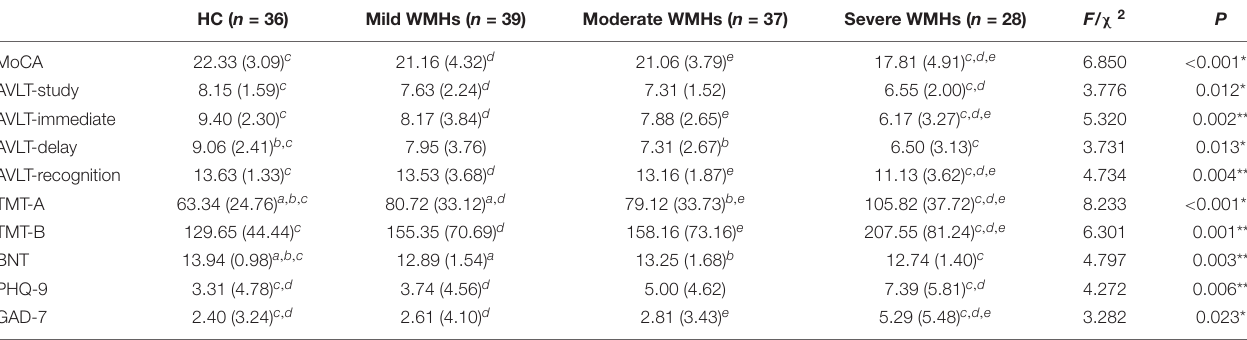
TABLE 3 | Neuropsychological tests of participants in the four groups [mean (SD)].